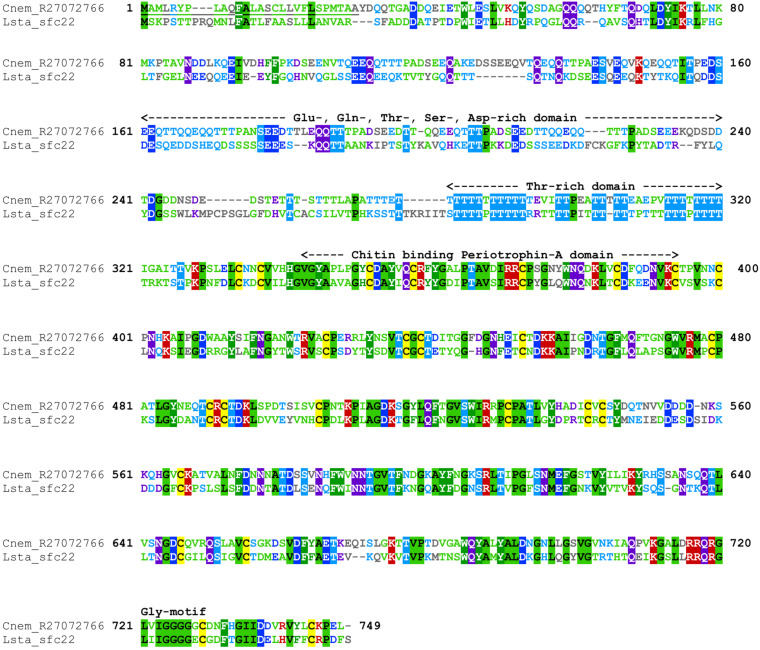
Annotated alignment of Cnem-R27072766 and Lstag-sfc_22. These orthologous shell-forming proteins (see Figure 2) each possess a signal sequence (underlined) and domains rich in Glu, Gln, Thr, Ser, and Asp. The locations of 24 Cys residues are conserved, and the chitin binding domain displays a high degree of sequence conservation. Cnem-R27072766 was identified from a proteomic screen of the C. nemoralis shell (Mann and Jackson, 2014) and Lstag_sfc_22 was identified from a proteomic screen of the L. stagnalis shell (Herlitze et al., 2018).